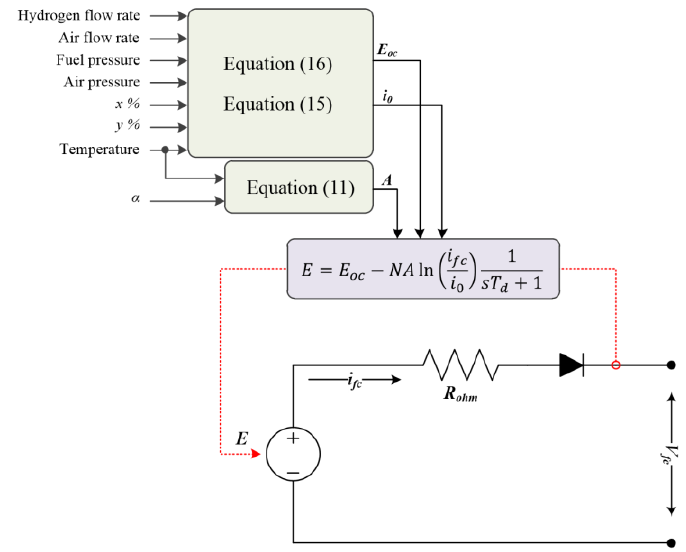
Figure 1. Block diagram of the overall equivalent circuit of the fuel cell.